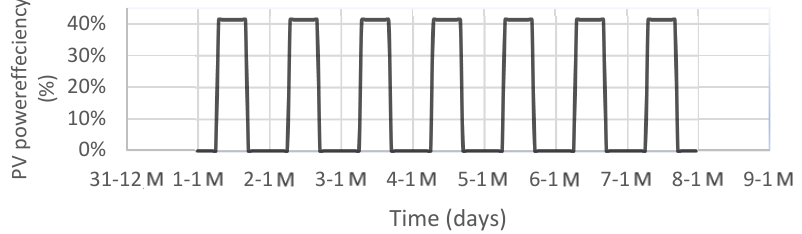
Figure 8. DC power efficiency (%) of the PV array for the first week of January.